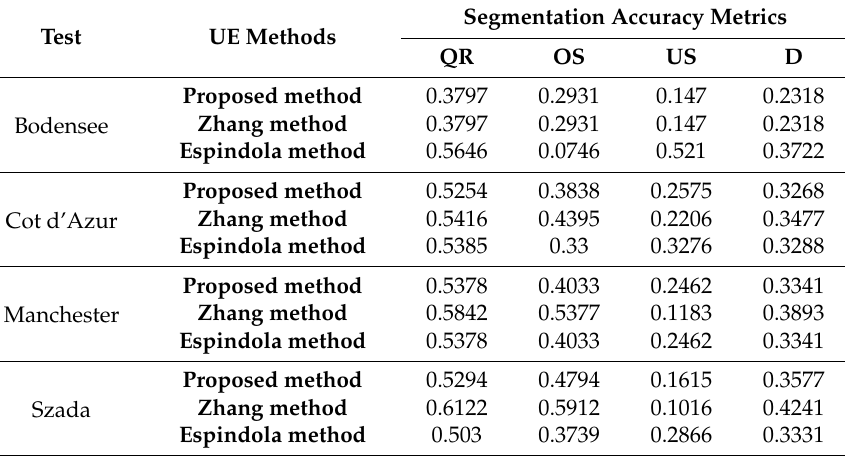
Table 4. The SE results for the segmentations produced with the different UE methods, using the SZTAKI-INRIA building detection